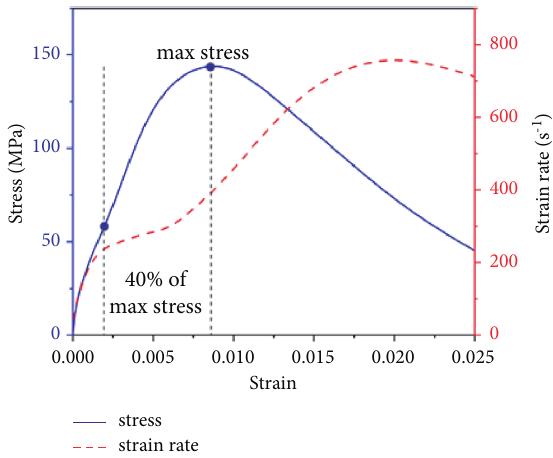
Figure 5: Determination of the strain rate in the